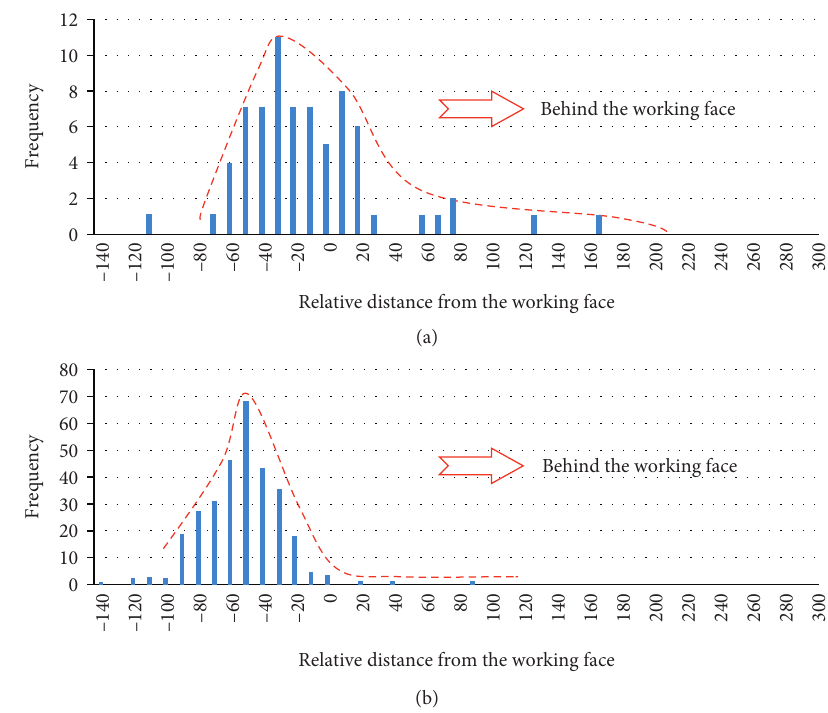
Figure 13: Frequency statistics of microseismic